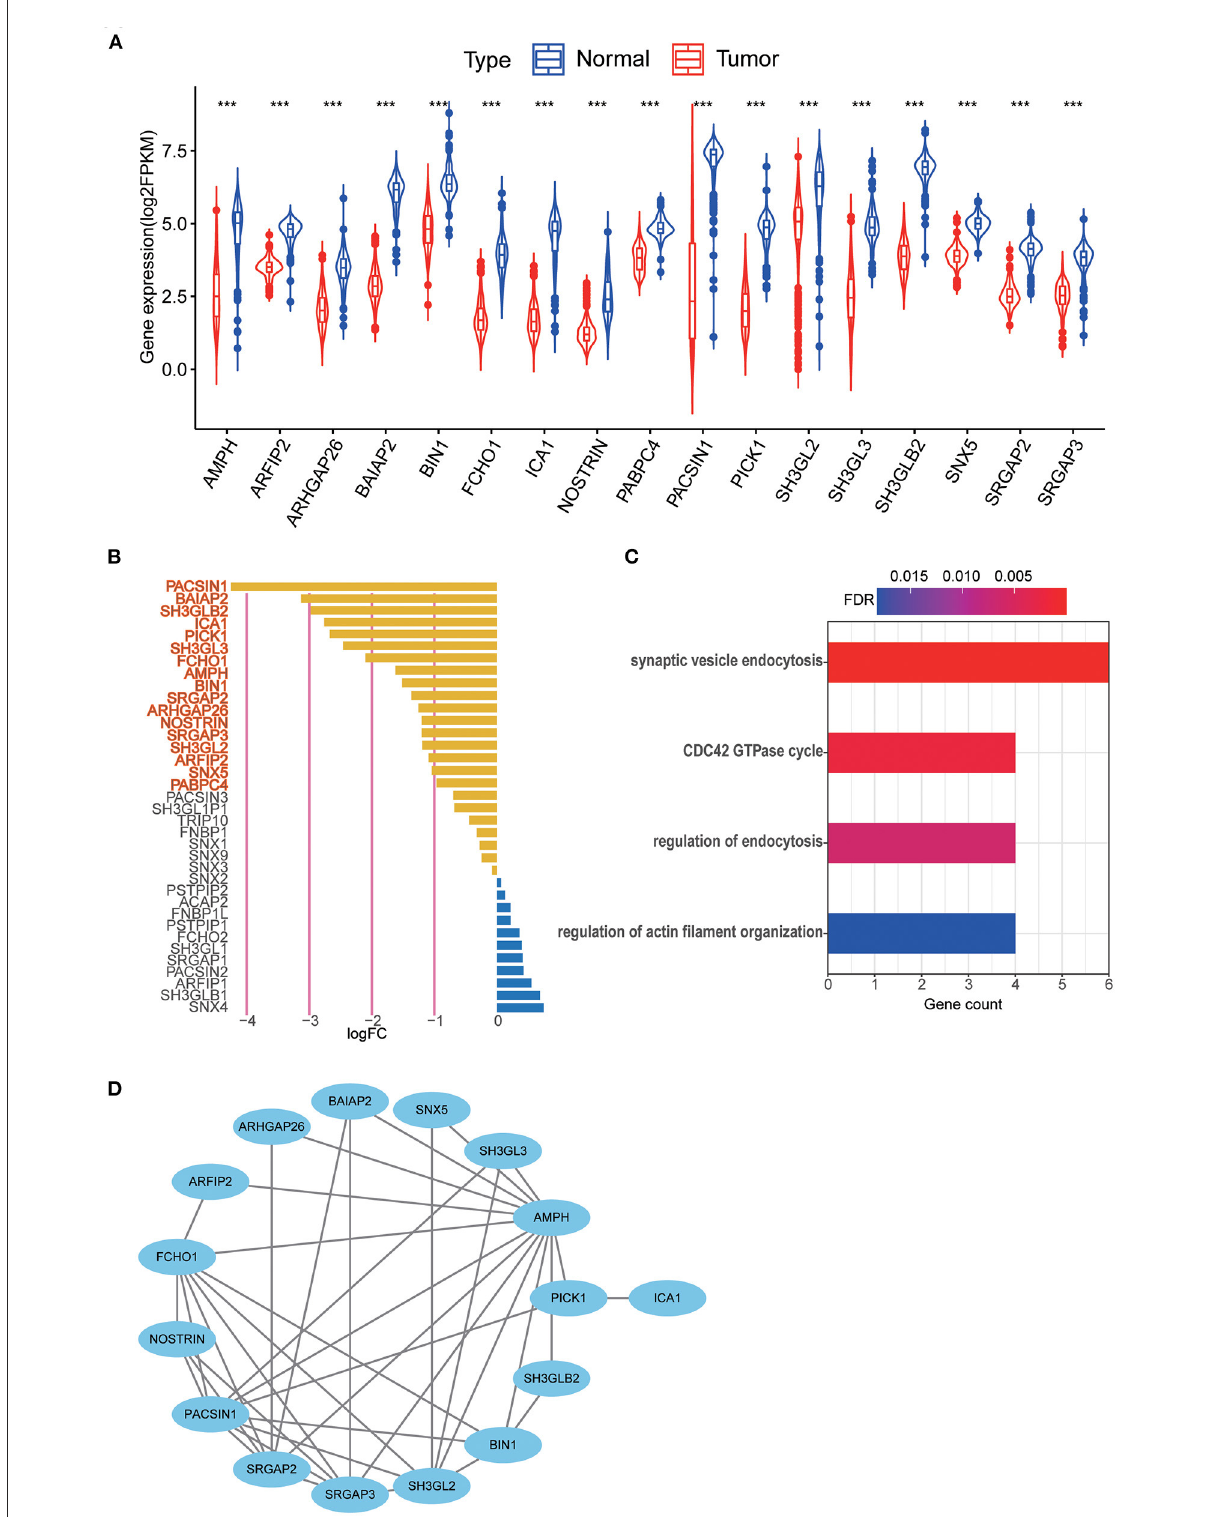
FIGURE2 (A) 17 MTRGs with significantly different expression between LGG tissue and normal tissue, *** p < 0.001. (B) Significantly different expressed genes were selected through absolute log2FC > 1, FDR < 0.05. Selected genes are in bold. (C) Functional analysis of 17 MTRGs in Metascape. (D) PPI of significantly differential expressed